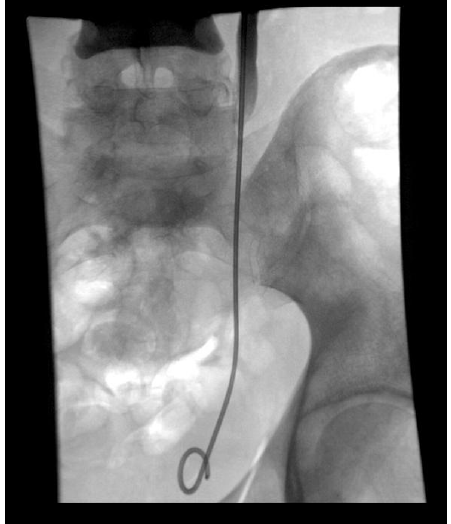
FIGURE 2. Case 2. Left hydroureteronephrosis with little antegrade flow, 2.5 months post–ureteral stent